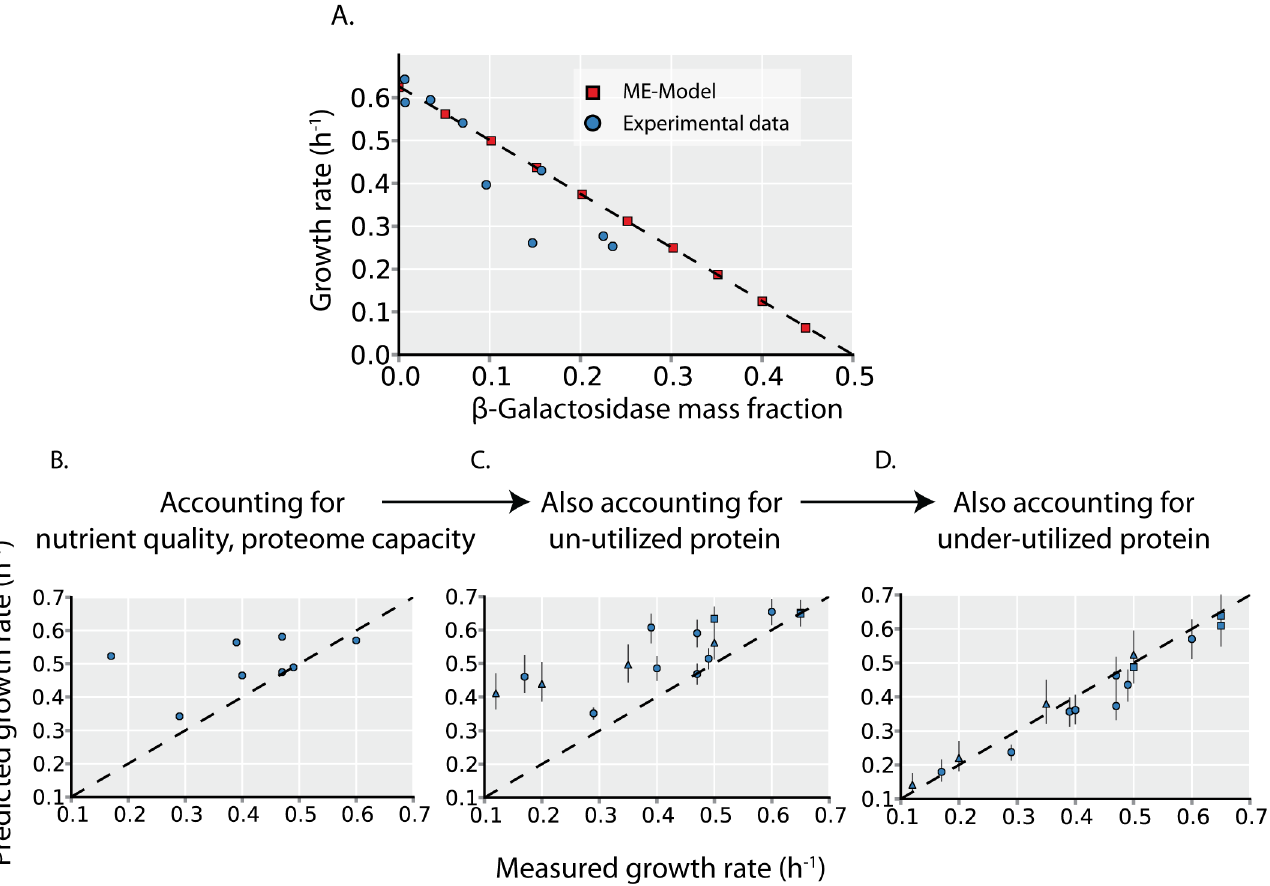
Fig 2. Growth rate is determined by unused protein expression. ( A ) To validate that the ME-Model accurately quantifies protein cost, we compare the predicted effect of un-utilized protein ( β -Galactosidase) overexpression (red squares) to experimental measurements (blue circles). Experimental data is obtained from Scott et al. [4] The x- and y- intercept from a linear regression (dotted line) is consistent with the phenomenological model of Scott et al. [4] The effects of the un-utilized and under-utilized protein expression (Fig 1) on growth rates are quantified in C and D. ( B ) Predicted growth rates are plotted versus measured growth rates during batch growth on 8 different carbon sources. Predicted growth rates are the computed maximal growth rates by the ME-Model, assuming the un-utilized proteome fraction and in vivo turnover rates are the same across all environments (see Methods, this assumption is eliminated in panels B and C to assess the effects of un- and under-utilized protein on growth). ( C ) Predicted maximal growth rates are computed with the ME-Model with the un-utilized proteome fraction set to the values inferred from proteomics data (see Methods and Fig 1C). In addition to the 8 carbon sources (circles), 4 glucose-limited chemostat cultures (triangles) and 4 stress conditions (squares) are also shown. These additional growth conditions are not included in panel A as growth rate predictions would require further information. ( D ) Predicted maximal growth rates are computed with the ME-Model with both the un-utilized proteome fraction and the in vivo turnover rate (indicative of under-utilized protein, Fig 1D) set to the values inferred from proteomics data. Point shape indicates environment type as in B (carbon source batch cultures = circles, glucose-limited chemostat cultures = triangles, stress conditions =